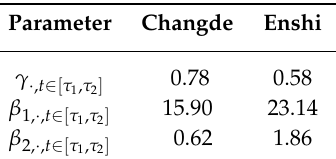
Table 3. Maximum Likelihood estimator for the mixture of two exponential distributions for the rainfall